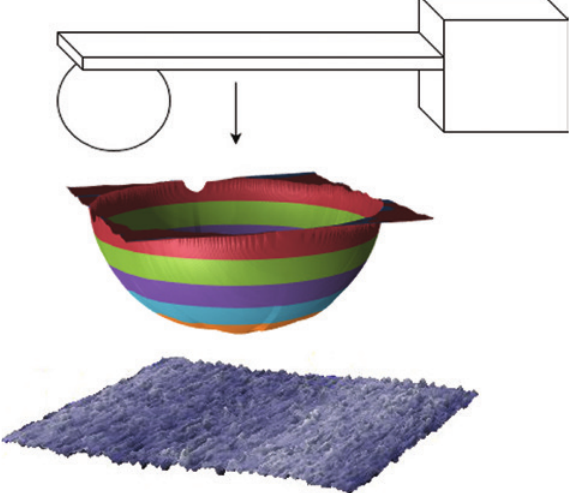
Figure 5: Schematics of the simulation validation method. A spherical surface that comes into contact with the sample is moved laterally. The spherical surface in the experiment is a cantilever tip; from the top, we can see a cantilever with a spherical tip; part of the sphere used to calculate the contact; polysilicon sample surface (with 20:1 ratio in the axis z with respect to x and y).